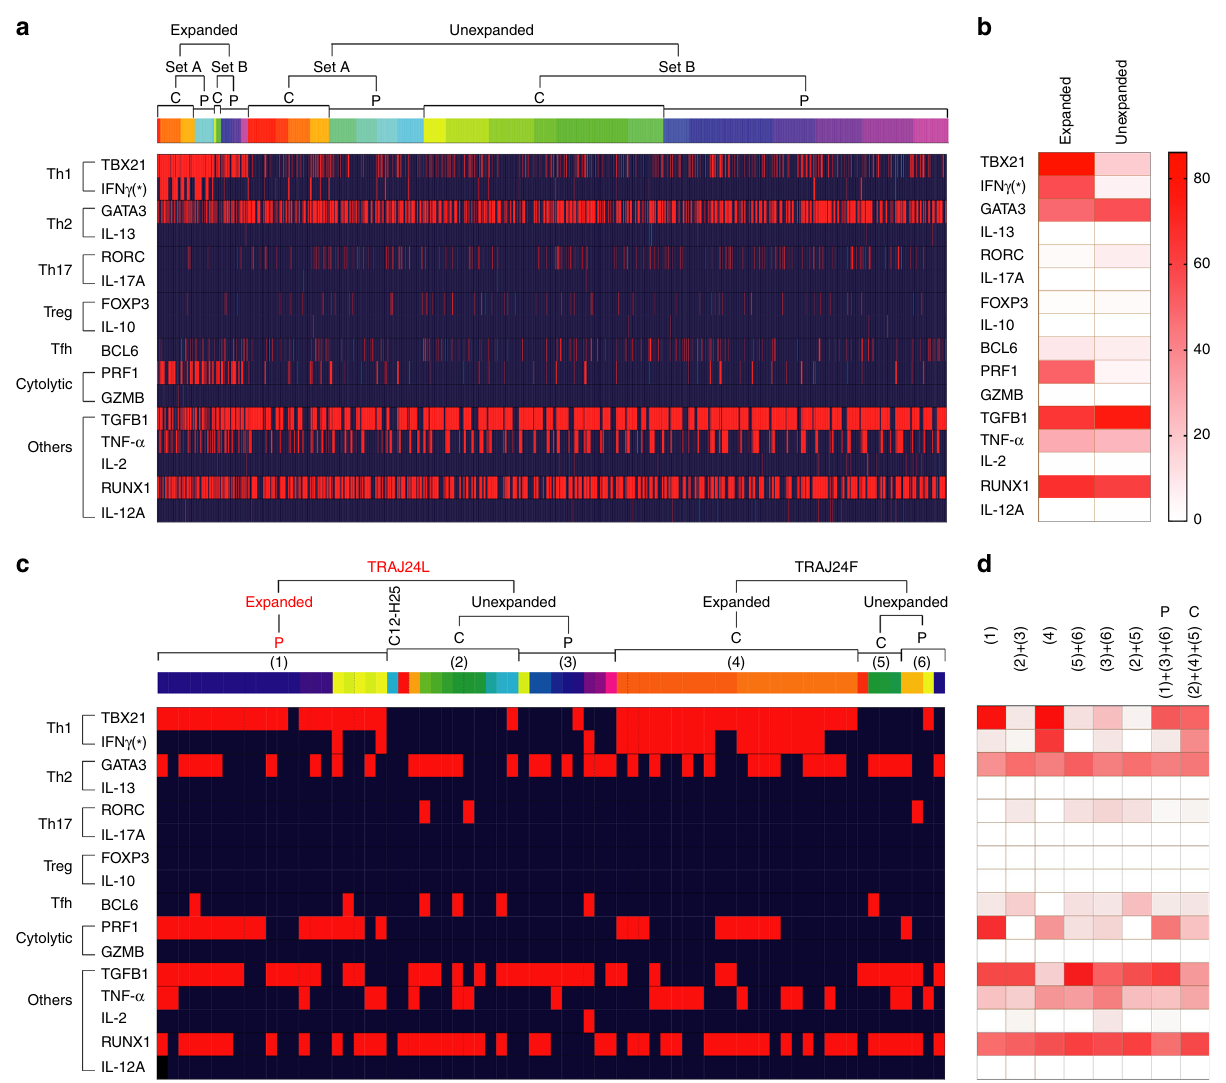
Fig. 7 Phenotypic features of tetramer + /CD4 + cells expressing the TRAJ24 gene. a Sequenced cells from controls (C) or patients (P) in each set (Table 1) are clustered as indicated. Each color in the horizontal bar above the heat map represents one donor. Red indicates the presence of mRNA in the cell. Genes to the left of the heat map are grouped according to their usage in different conventional T cell subsets 23 . *Different sets of primers were used to amplify IFN- γ mRNAs in cells from Set A and Set B donors. b Frequencies of expanded versus unexpanded cells expressing the indicated transcript. c Phenotypes of expanded or unexpanded TRAJ24L + clones versus TRAJ24F + clones. Each color in the horizontal bar represents one subject-tetramer category of single cells. Patients (P) or controls (C) are clustered as indicated. The expanded TRAJ24L (red font) cluster includes the unexpanded clonotype from P3, as it only differs from other eTRAJ24L clonotypes from the same patient by 1 residue in both α / β CDR3 sequences. d Frequencies of cells from the indicated cluster expressing the indicated transcript in c . The scale of color intensity is the same as in